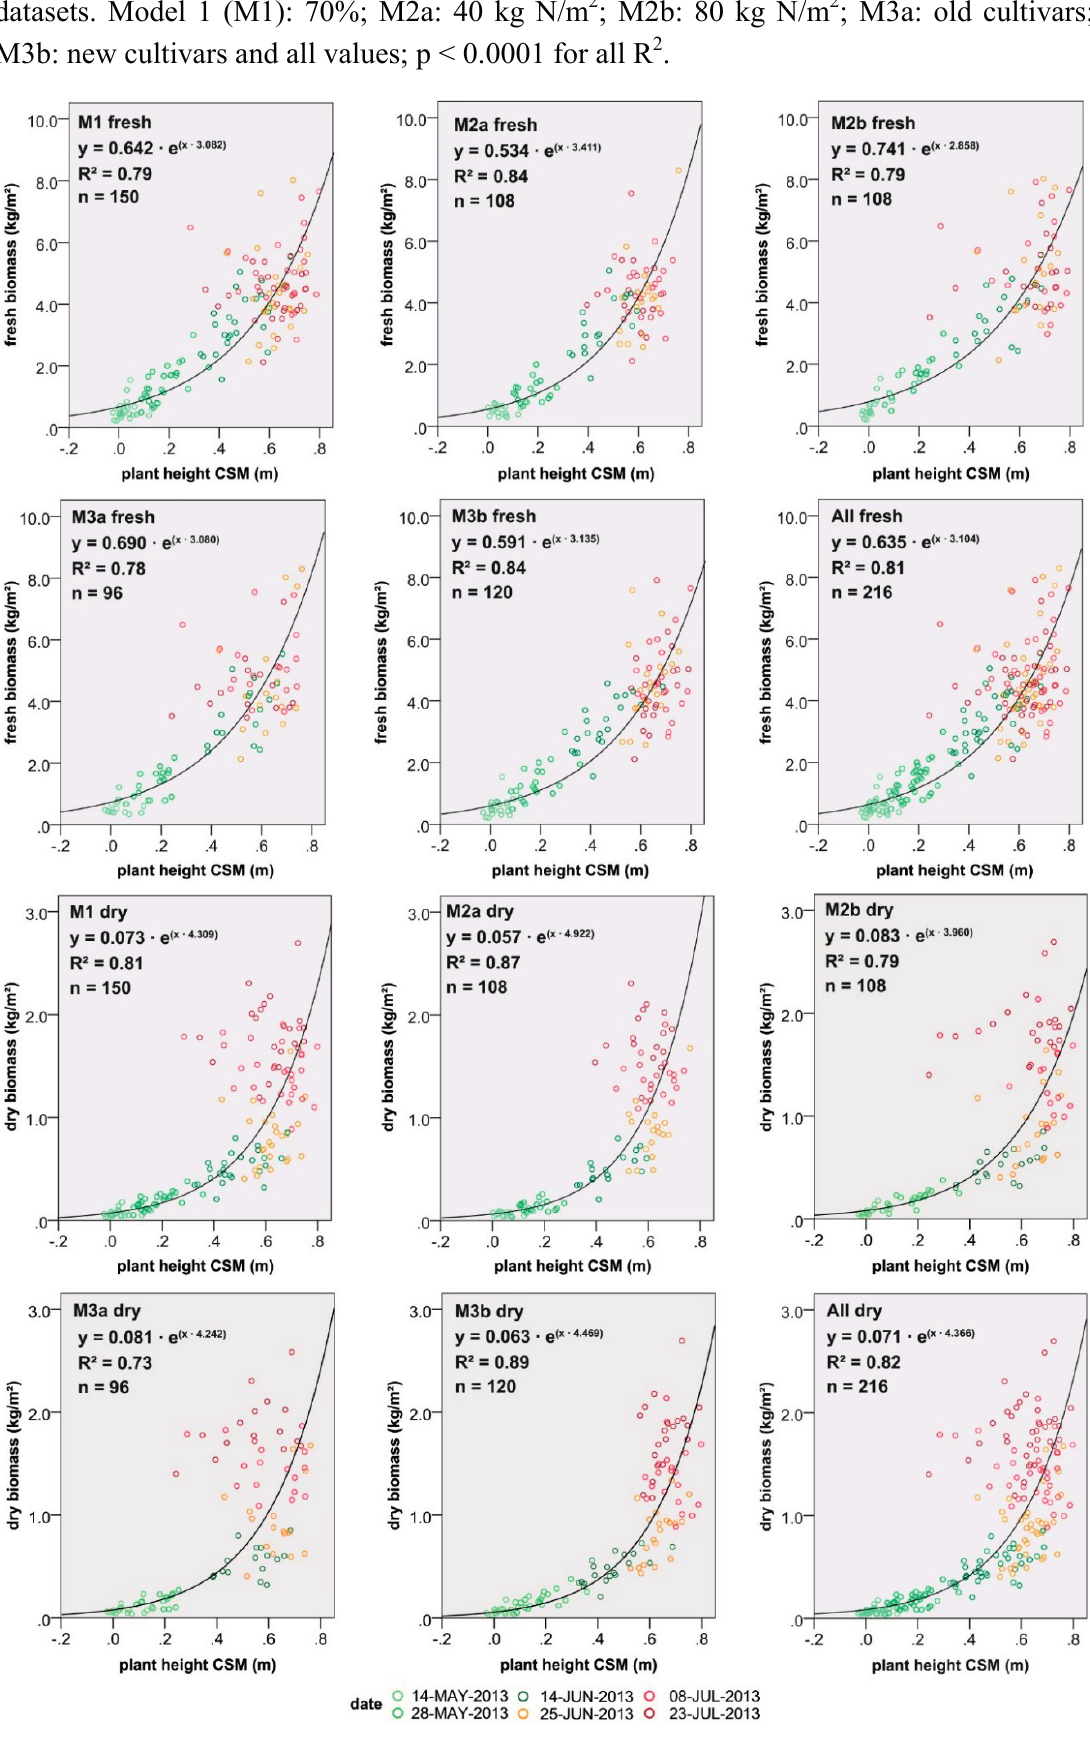
for calibration PH